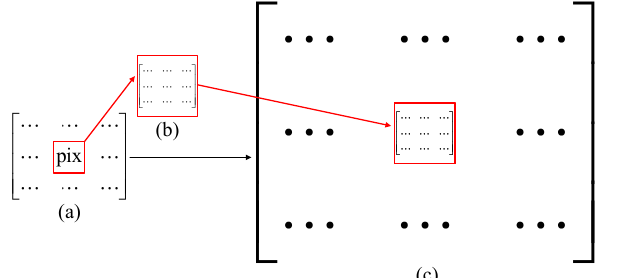
Figure 11. Schematic diagram of encoding a grayscale image onto a DMD. ( a ) shows the pixel size for reconstruction, ( b ) gives an example of an pixel-unit “pix”, and ( c ) is the actual pixel size displayed on the